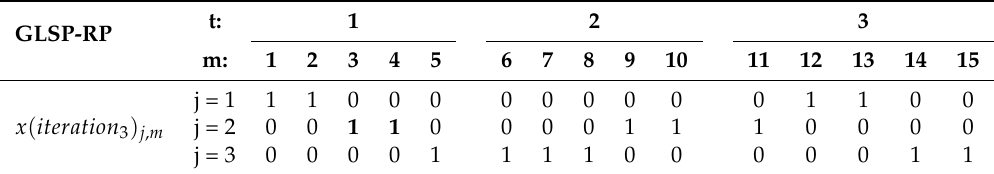
Table 8. Production sequence of Iteration 3 for the